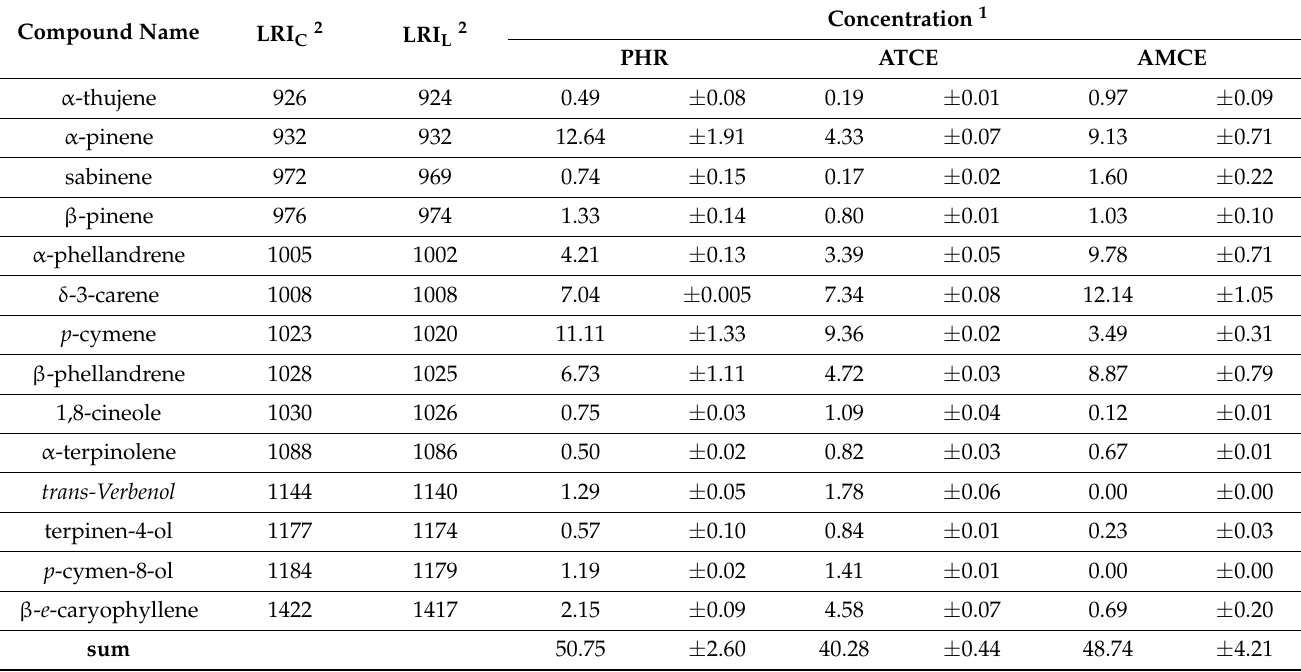
Table 1. Volatile organic compound (VOC) identification and quantification in Protium heptaphyllum resin (PHR), acidic triterpene concentrated extract (ATCE) and α and β -amyrin concentrated extract (AMCE)